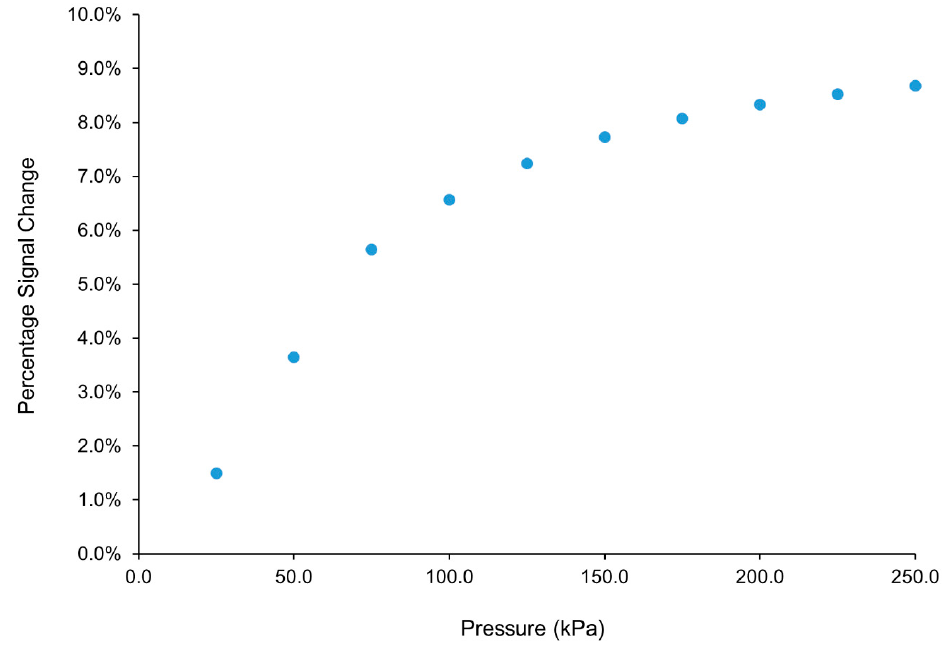
Figure A6. Compression of the ferrous liner at a fixed distance increased the signal.